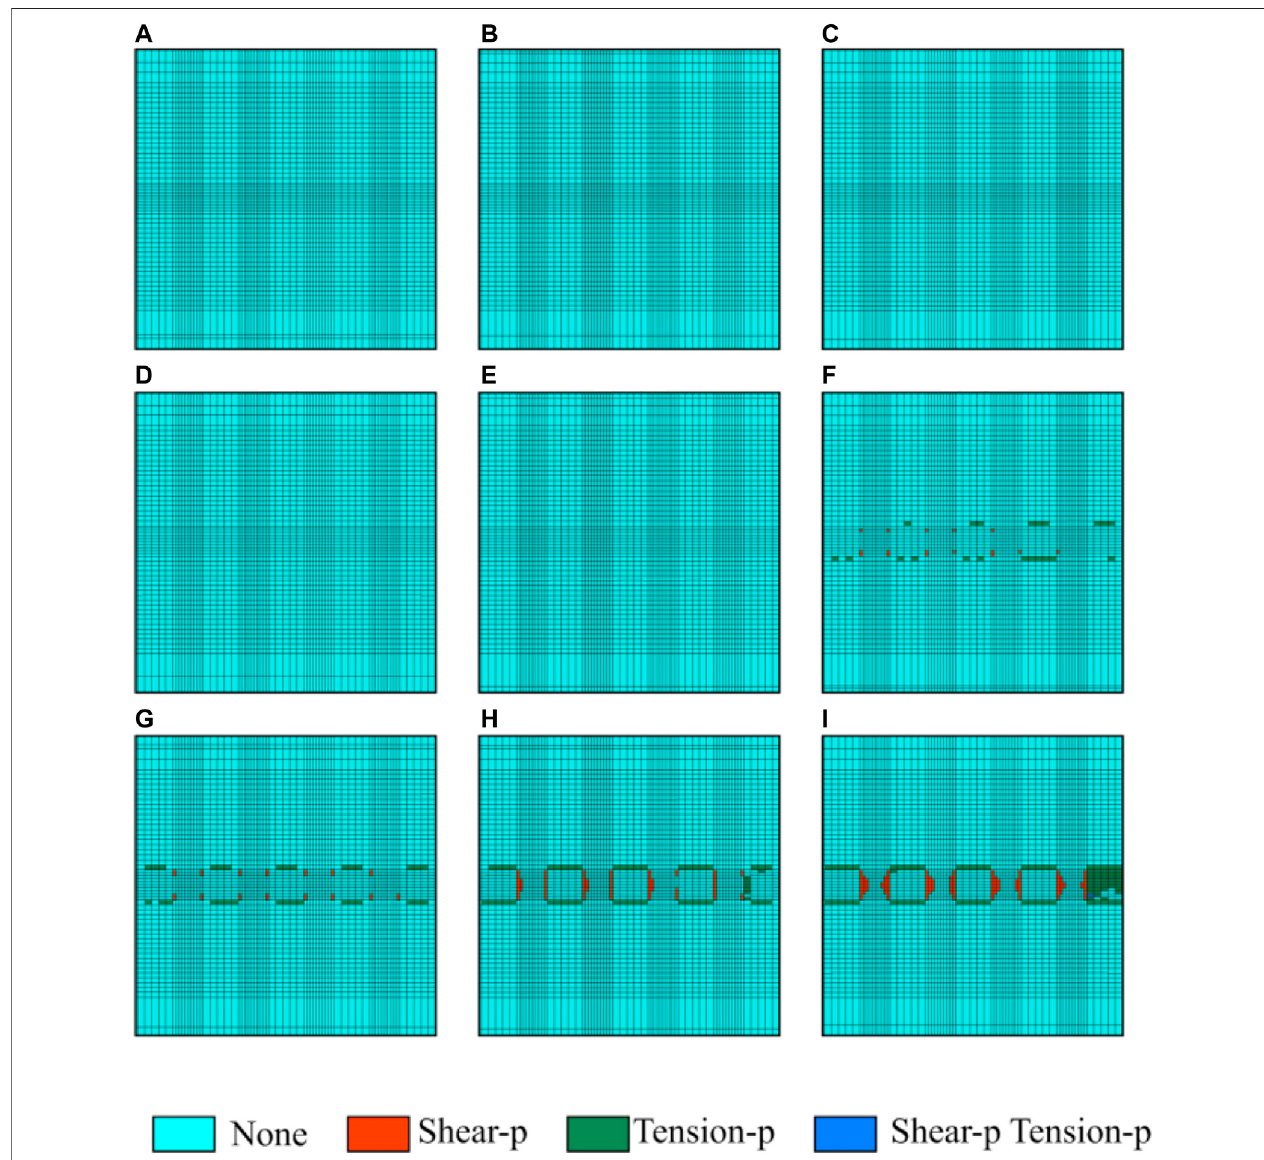
FIGURE 9 | Average width of the inelastic zone of the coal pillar in each section under the 100% fi lling rate condition. (A) 50 m; (B) 85 m; (C) 120m; (D) 155 m; (E) 190 m; (F) 225 m; (G) 260 m; (H) 295 m; and (I) 330 m.